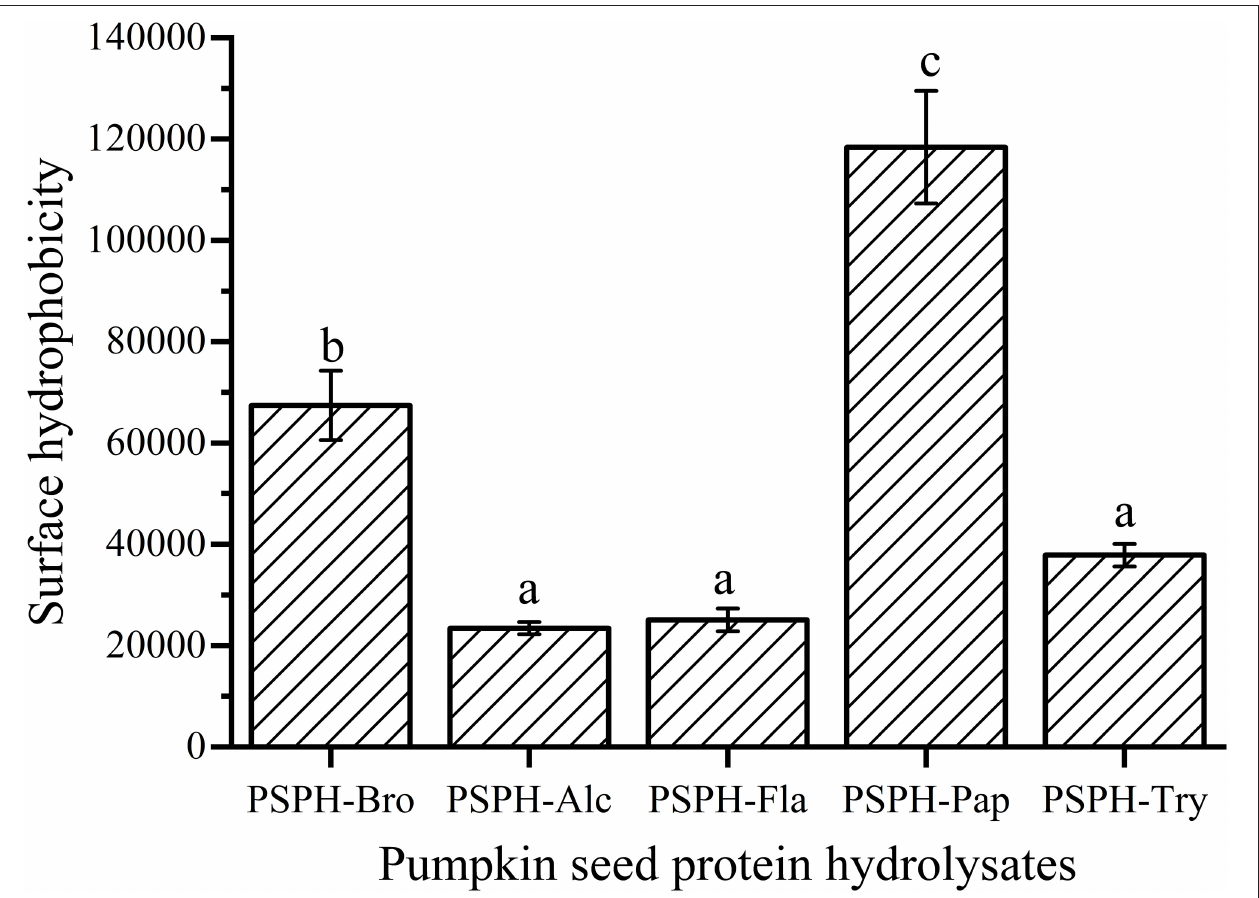
FIGURE 4 | Surface hydrophobicity of pumpkin seed protein hydrolysates produced with bromelain (PSPH-Bro), alcalase (PSPH-Alc), flavourzyme (PSPH-Fla), papain (PSPH-Pap), trypsin (PSPH-Try) after hydrolysis 3h in a 2% (w/w) enzyme to substrate ratio. Different letters represent significantly different mean values with P < 0.05.